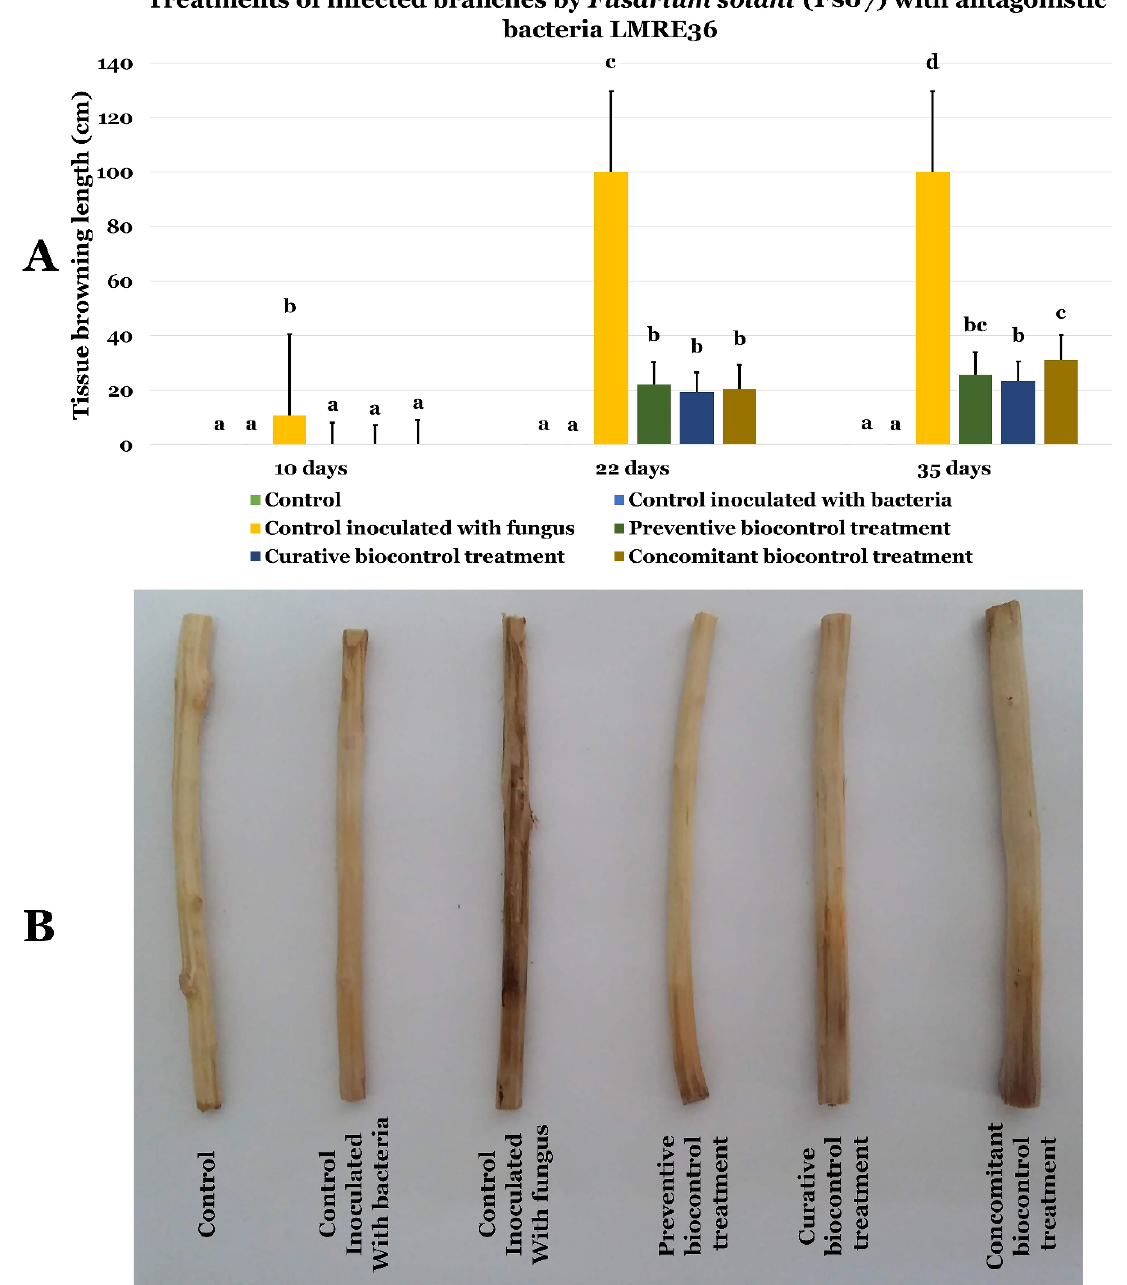
Figure 14. ( A ) Effects of LMRE 36 bacterial isolates on Fusarium solani strain Fso7 on olive tree shoots rot severity as compared to controls. ( B ) Effect of preventive, concomitant, and curative biocontrol treatment on olive tree shoots at 10, 22 and 35-days post-inoculation with Fusarium solani strain Fso7. Data presents mean ± standard error. Bars labelled with different letters are significantly different among the treatments at p < 0.05 using Tukey’s HSD test.